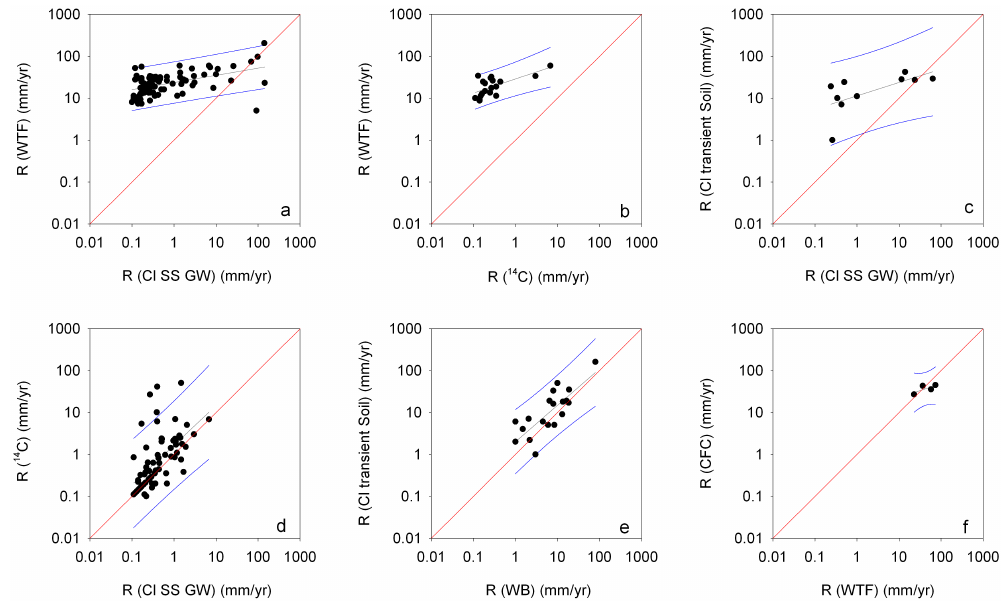
Fig. 4. Comparison of the different methods where two methods have been used at the same site by the same author.